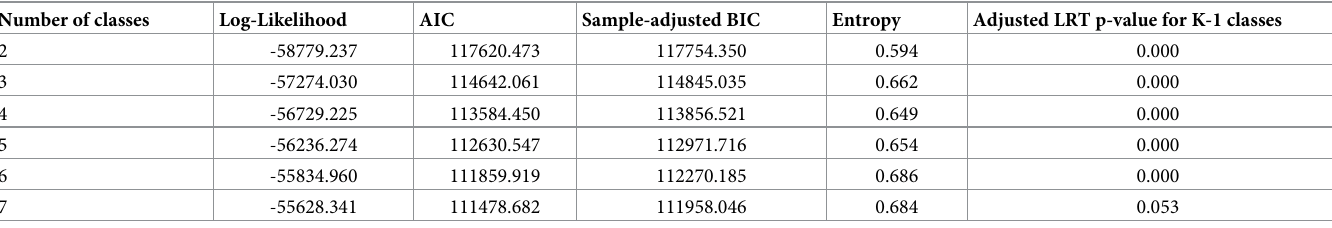
Table 4. Selection of number of classes for the CMs’ generation (G2). Indicators of Model Fit. Number of